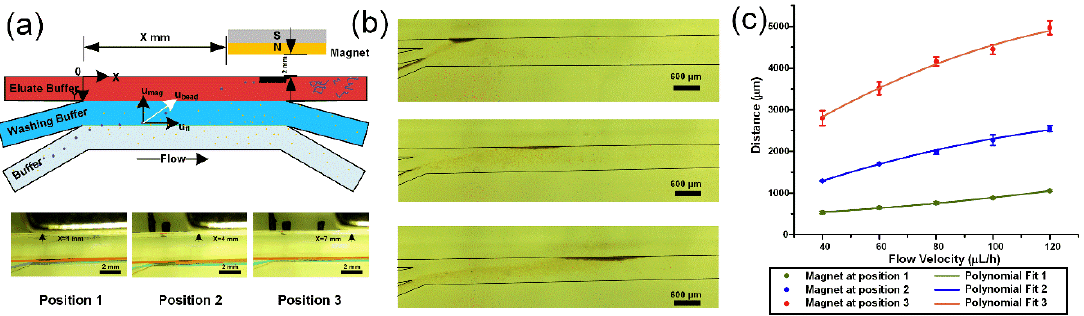
Figure 4. ( a ) The schematic and photos of magnetic beads purification of DNA on a chip. ( b ) All the magnetic beads were deflected to the wall in the upper picture ( x = 1 mm, 𝑢 𝑓𝑙 = 120 μ L/h); x = 4 mm, 𝑢 𝑓𝑙 = 120 μ L/h in the middle picture; only a few of beads sloped to the wall before entering the main channel in the bottom picture ( x = 7 mm, 𝑢 𝑓𝑙 = 120 μ L/h). ( c ) Fitting curve of distance between arriving position of beads and origin with the 𝑢 𝑓𝑙 from 40 μ L/h to 120 μ L/h.